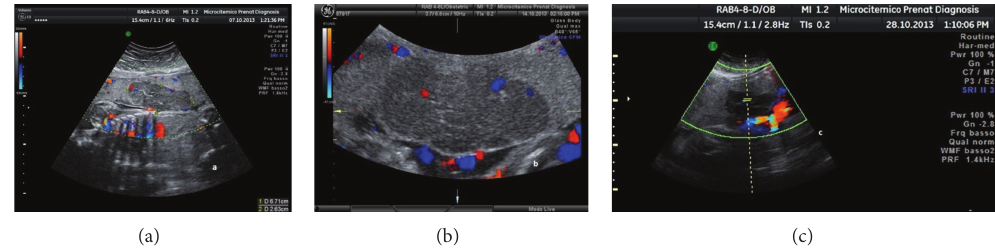
Figure 1: (a) At ultrasound the mass was hypoechogenic, sharply marginated, and circumscribed by a hyperechoic capsule, from which numerousintralesionalseptaappearedtooriginate,withsomeanechoiccentralareasofvasculatureandperipheralvessels(thefeedingvessel). Score assigned is 3. (b) Successive examination score assigned is 3. (c) Score assigned is 2.